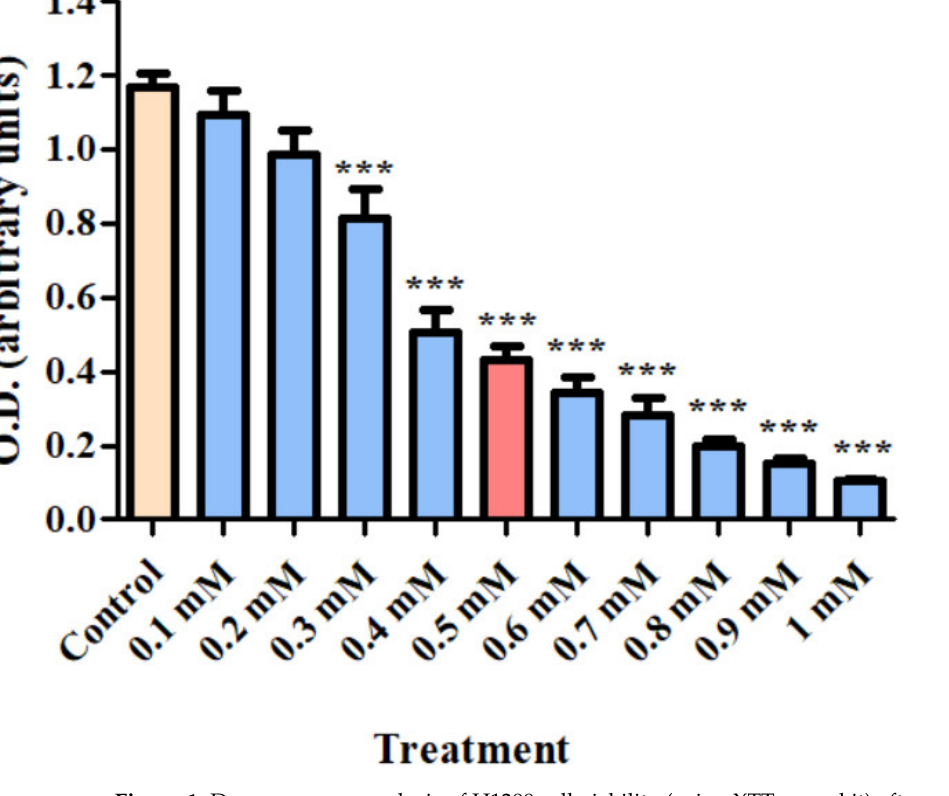
Figure 1. Dose–response analysis of H1299 cell viability (using XTT assay kit) after exposure for 24 h to CoCl 2 (0.1–1 mM). Results are expressed as mean ± SD (8 replicates for each group). *** p < 0.001 compared to control.